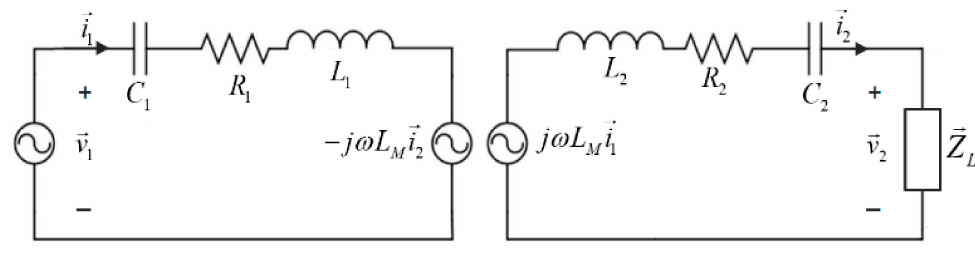
Figure 3. Equivalent phasor-domain